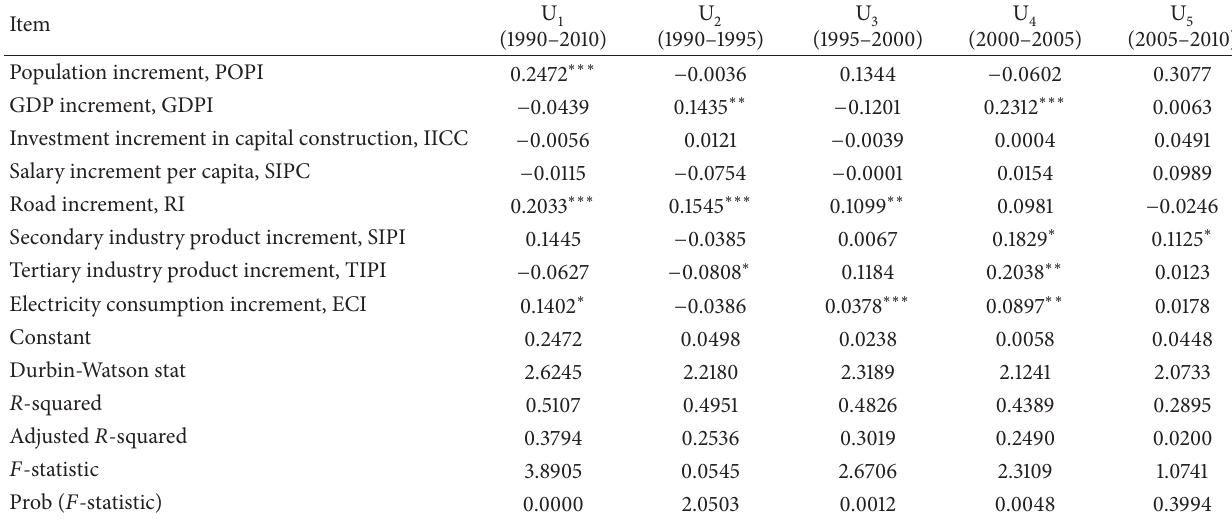
Table 4: Urban expansion and driving factors in Eastern